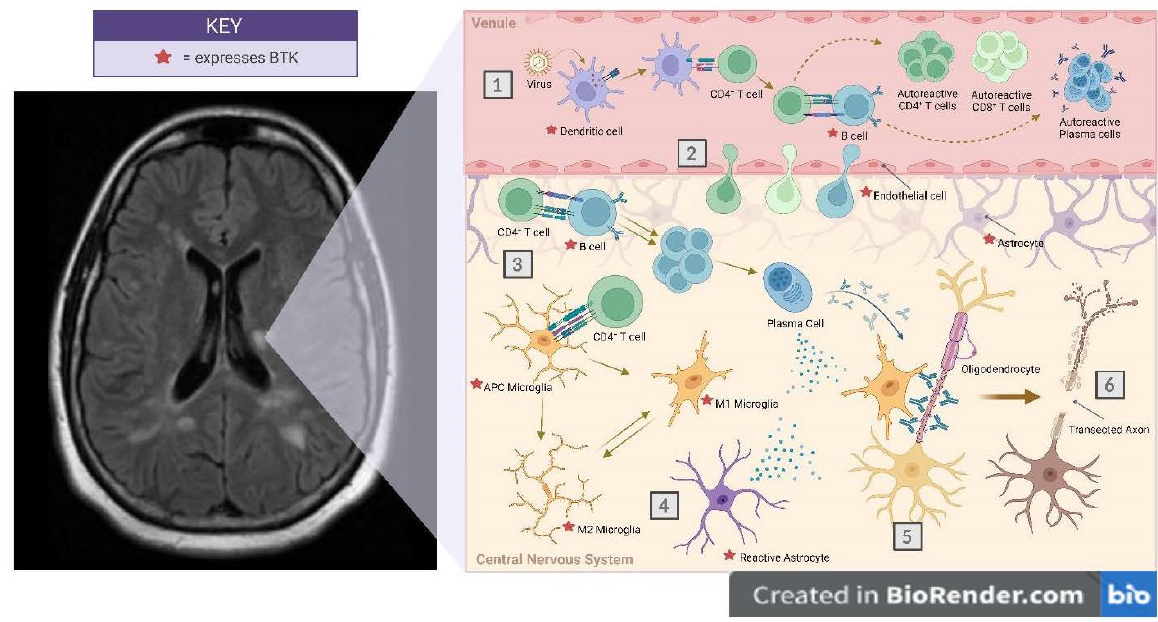
Figure 3. Systemic and CNS events leading to the formation of the MS plaque are schematically demonstrated, with the various cells involved in the occurrence of the inflammatory demyelinating lesion. Cells expressing BTK are tagged with the red